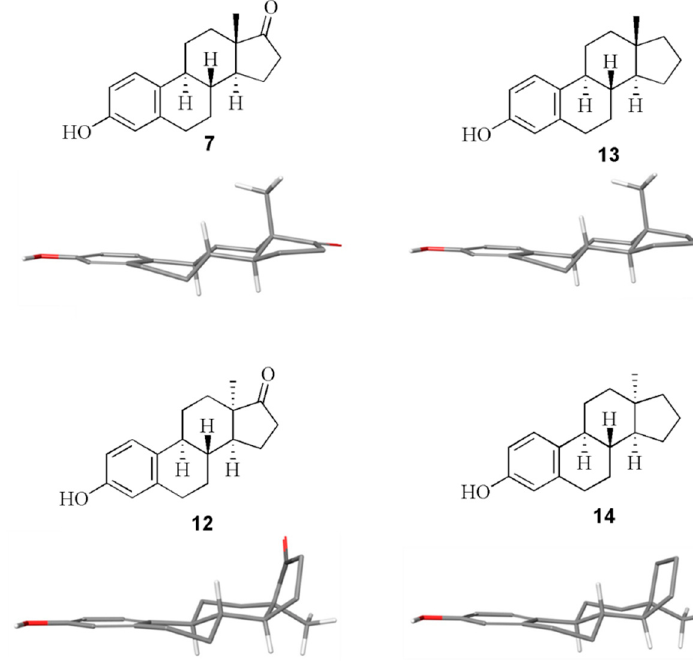
Figure 1. The structure of 13-epimeric estrones ( 7 and 12 ) and their 17-deoxy counterparts ( 13 and 14